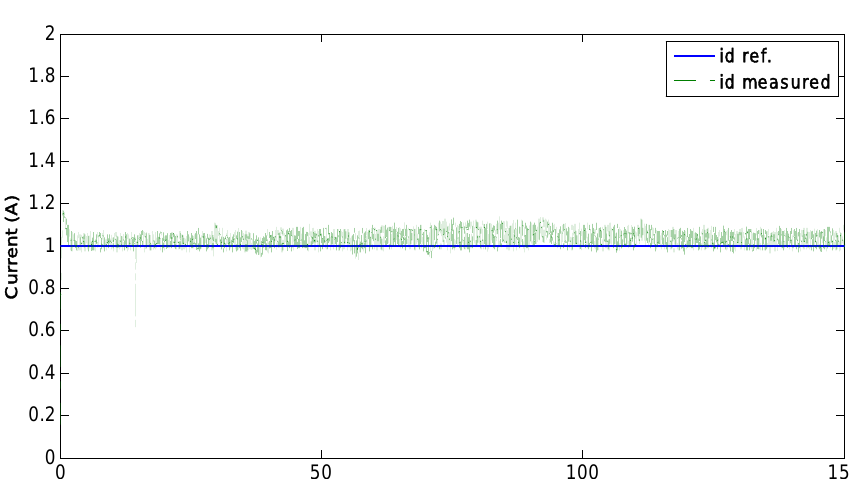
Figure 10. Response of the controlled rotor q -current.